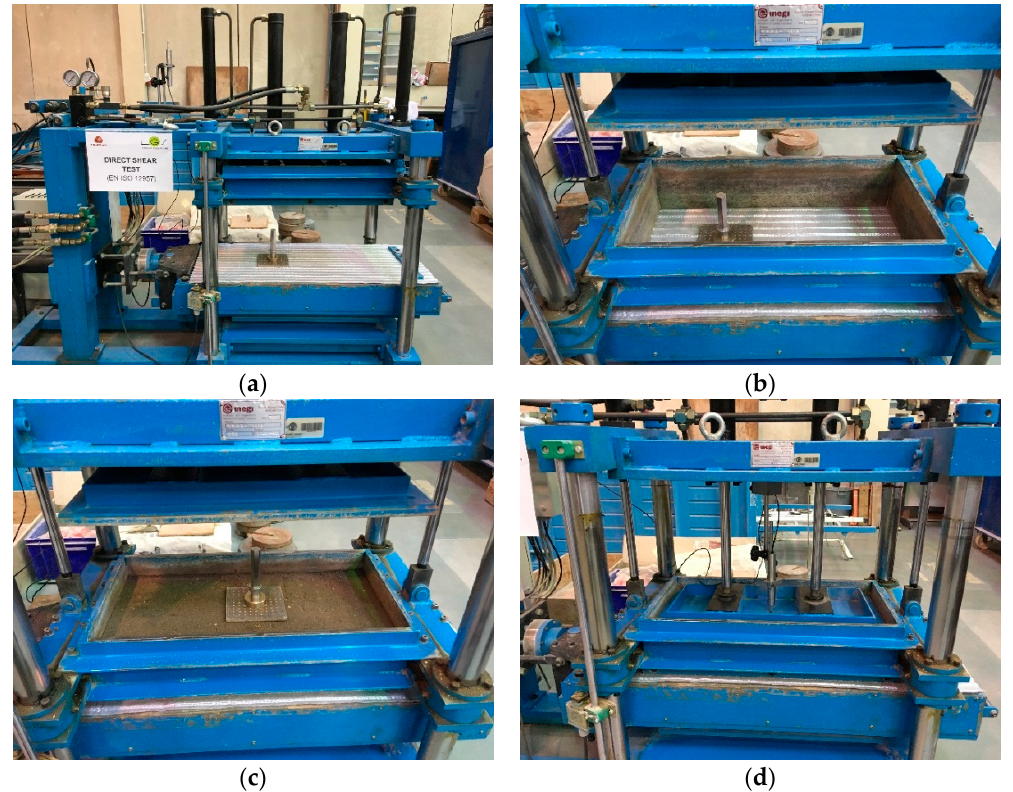
Figure 3. Large-scale direct shear apparatus and test procedures: ( a ) Geotextile specimen fixed to the lower box; ( b ) Upper box positioned over the geotextile; ( c ) Upper box filled with compacted recycled C&D material; ( d ) Direct shear box ready for